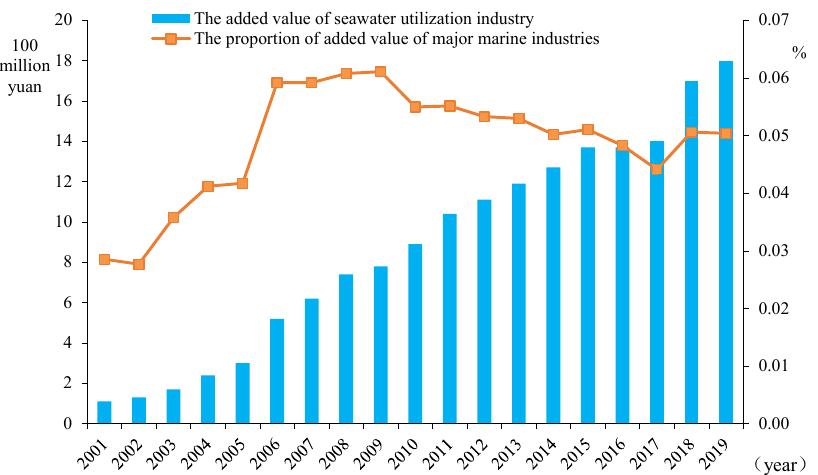
Figure 16. Data of